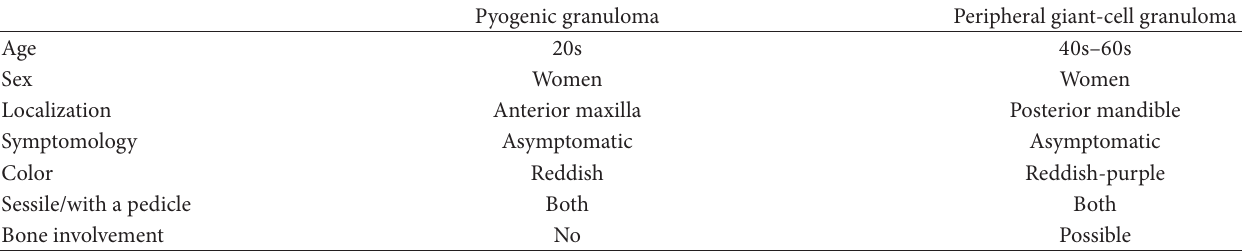
Table 1: Summarizing the differential diagnosis between pyogenic granuloma and peripheral giant-cell